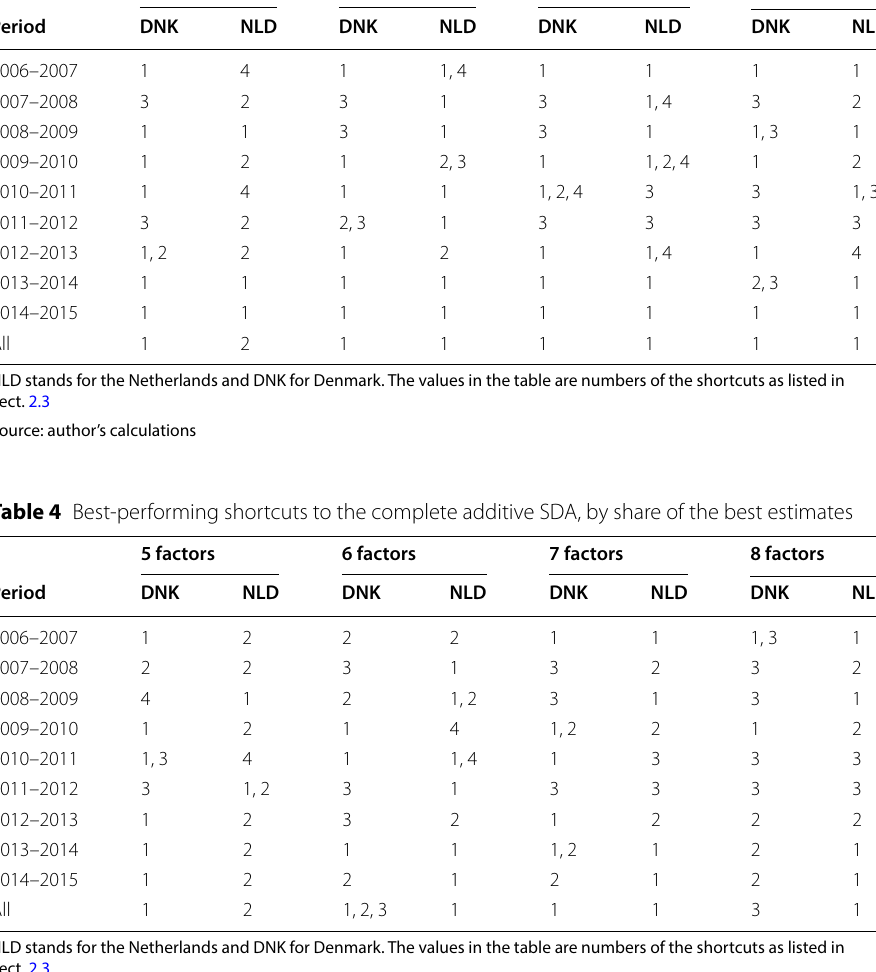
NLD stands for the Netherlands and DNK for Denmark. The values in the table are numbers of the shortcuts as listed in Sect.